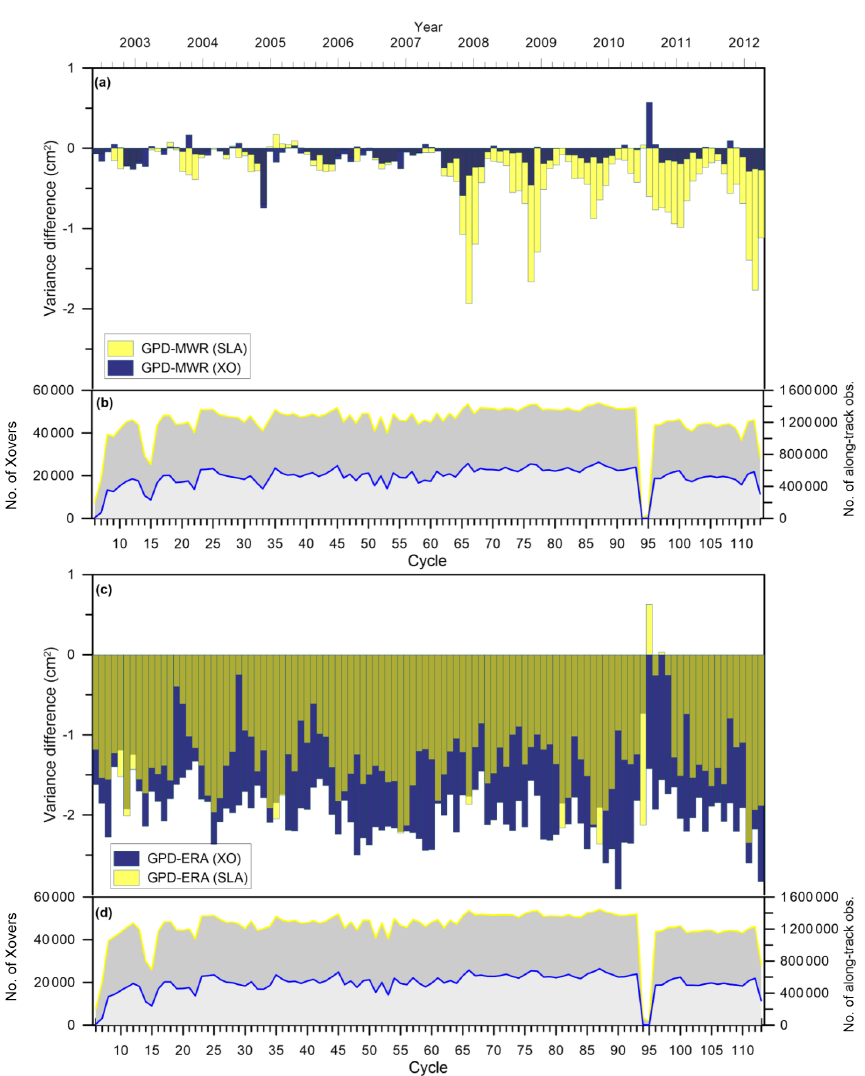
Figure 11. Temporal evolution of weighted SLA variance differences (cm 2 ) along satellite tracks (yellow) and at crossovers (blue) between (a) GPD + and the MWR-derived WTCs and (c) GPD + and ERA-Interim WTCs. Plots (b) and (d) show the number of crossovers (“No. of Xovers”, blue) and the number of along-track (yellow) pairs used, per cycle, in the GPD-MWR and GPD-ERA analyses, respectively. To facilitate the analysis, both cycle number (bottom x axis) and time (year, top x axis) are